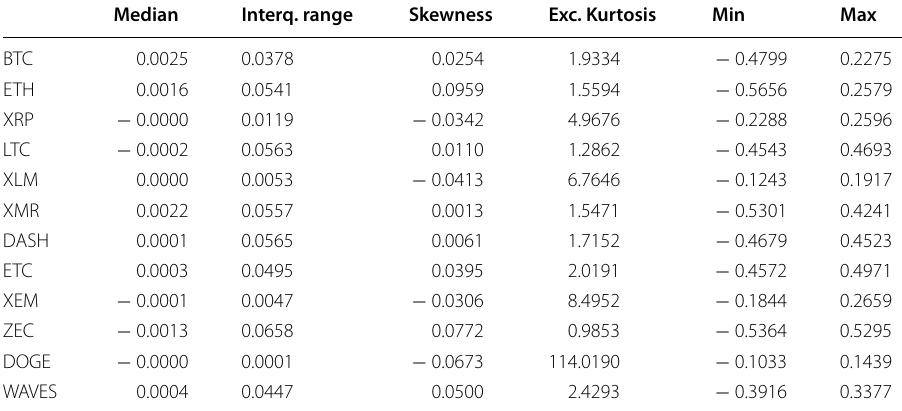
Table 1 Sample statistics of the 12 CCs’ log return considered Median Interq. range Skewness Exc. Kurtosis Min